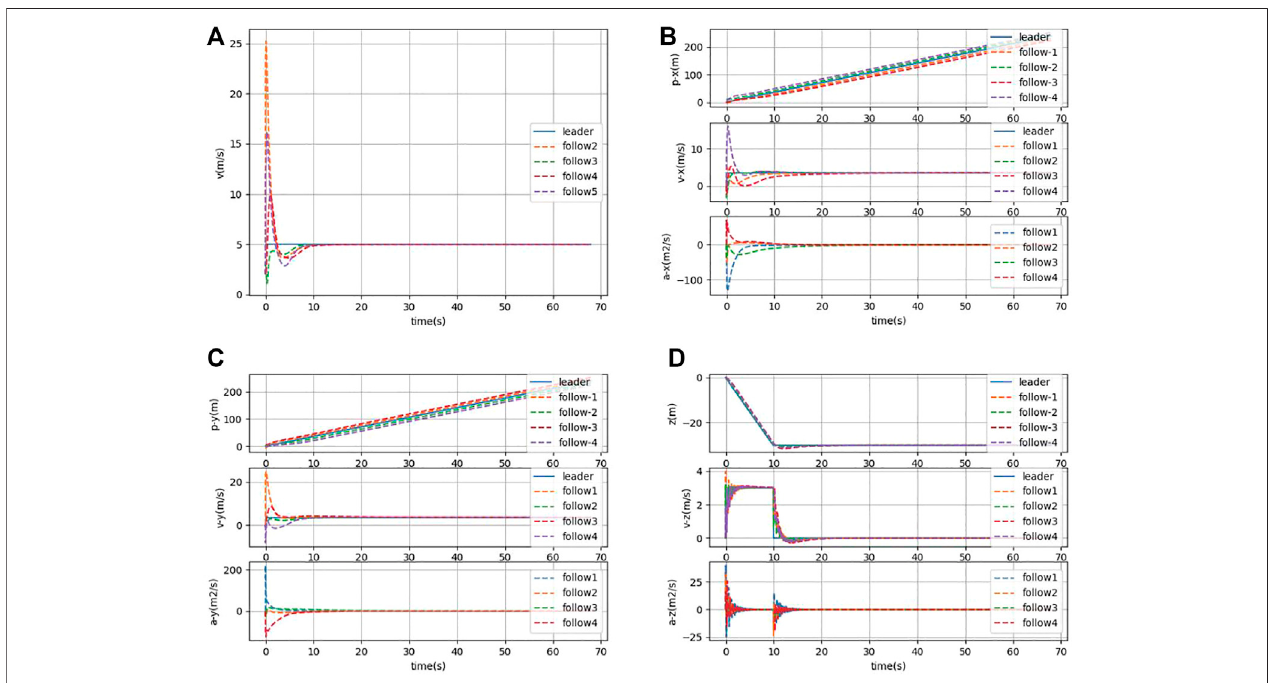
FIGURE8|(A) CombinedvelocityoftheheterogeneousAUVgroupinthe x , y ,and z directionsundercommunicationdelay. (B) Position,velocity,andacceleration states oftheheterogeneous AUV group inthe x -direction under communication delay. (C) Position, velocity, and acceleration states ofthe heterogeneous AUV group in the y -directionundercommunicationdelay. (D) Position,velocity,andaccelerationstatesoftheheterogeneousAUVgroupinthe z -directionundercommunicationdelay.